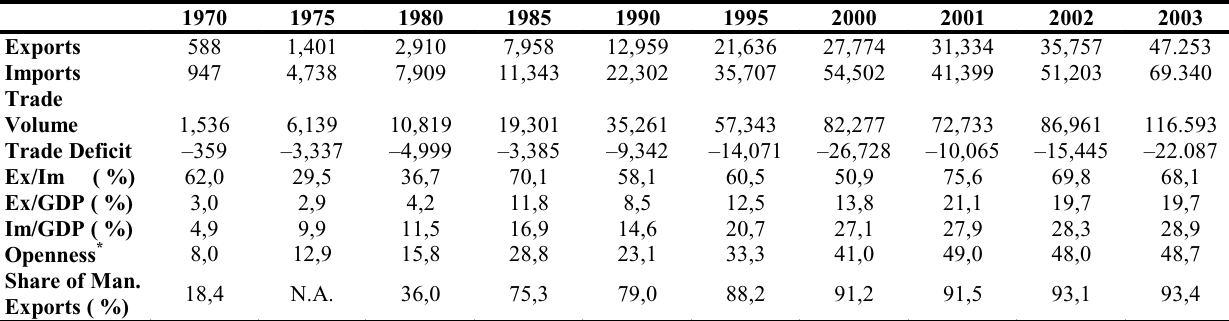
Table 1 . Key Foreign Trade Indicators of Turkey, 1970–2003 (Billion